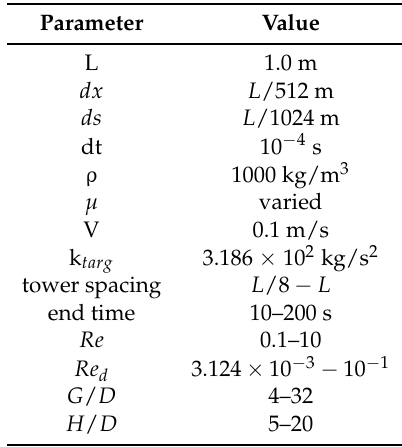
Table 2. Numerical parameters used in the three-dimensional